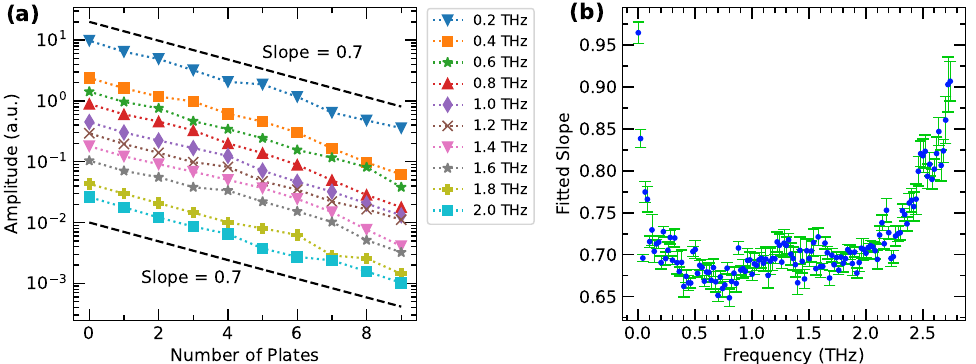
Figure 5. ( a ) Measured transmitted amplitude as a function of the number of Si plates, for different frequencies. Dashed lines show the expected slope. ( b ) The fitted slopes for all frequencies up to 2.7THz. For clarity, only every 20th datapoint is